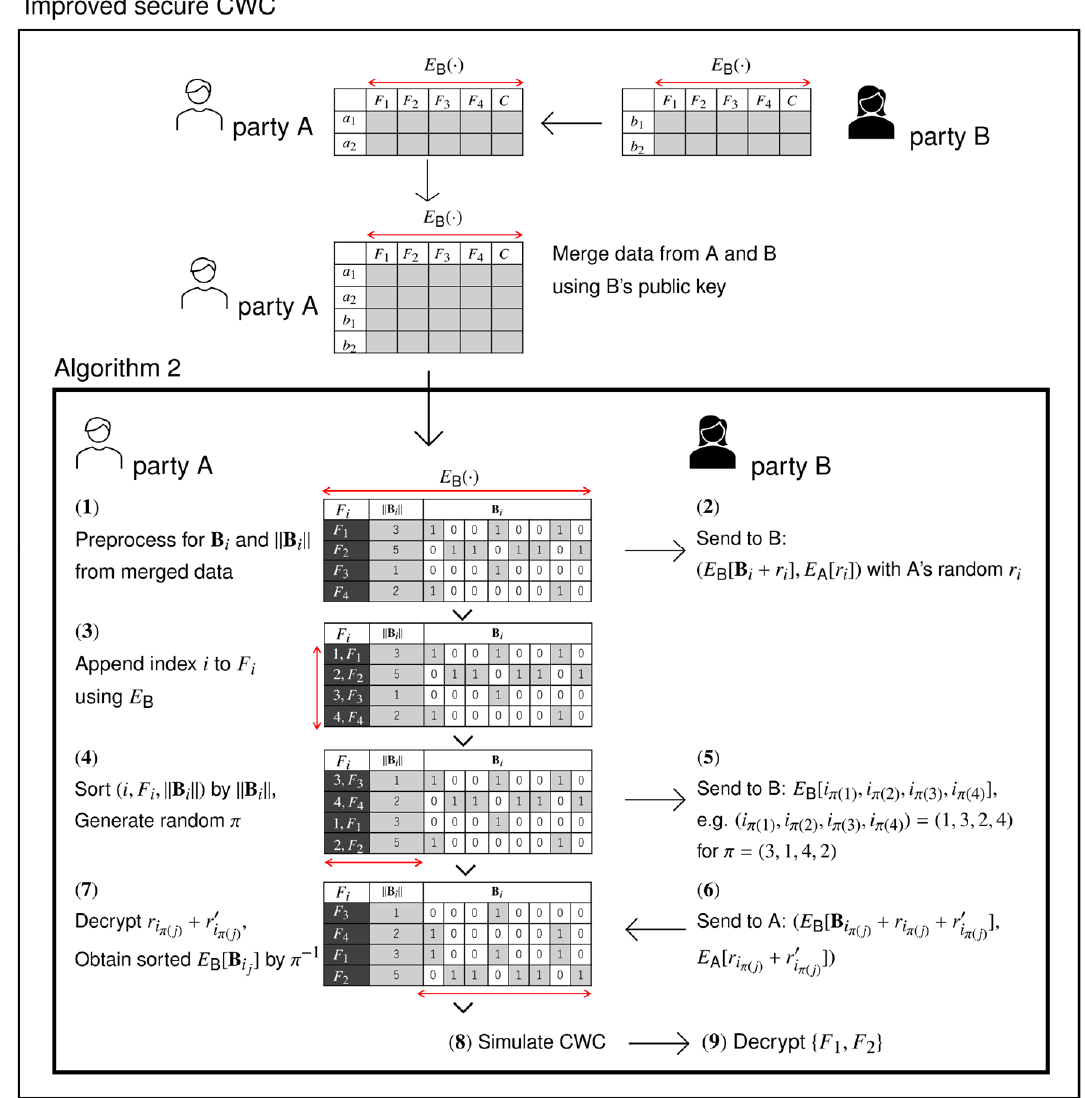
Figure 1. An example run of Algorithm 2. For simplicity, we omit the clock time in each